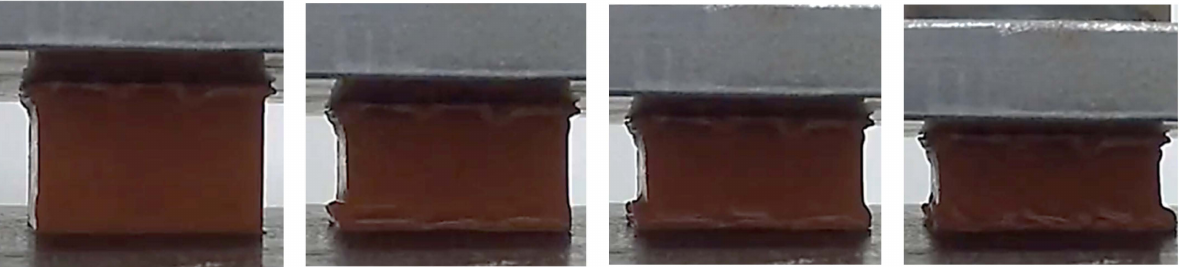
Figure 14. Experimentally-observed deformation sequence of one representative sample of regular- scale hexagonal honeycomb undergoing axial